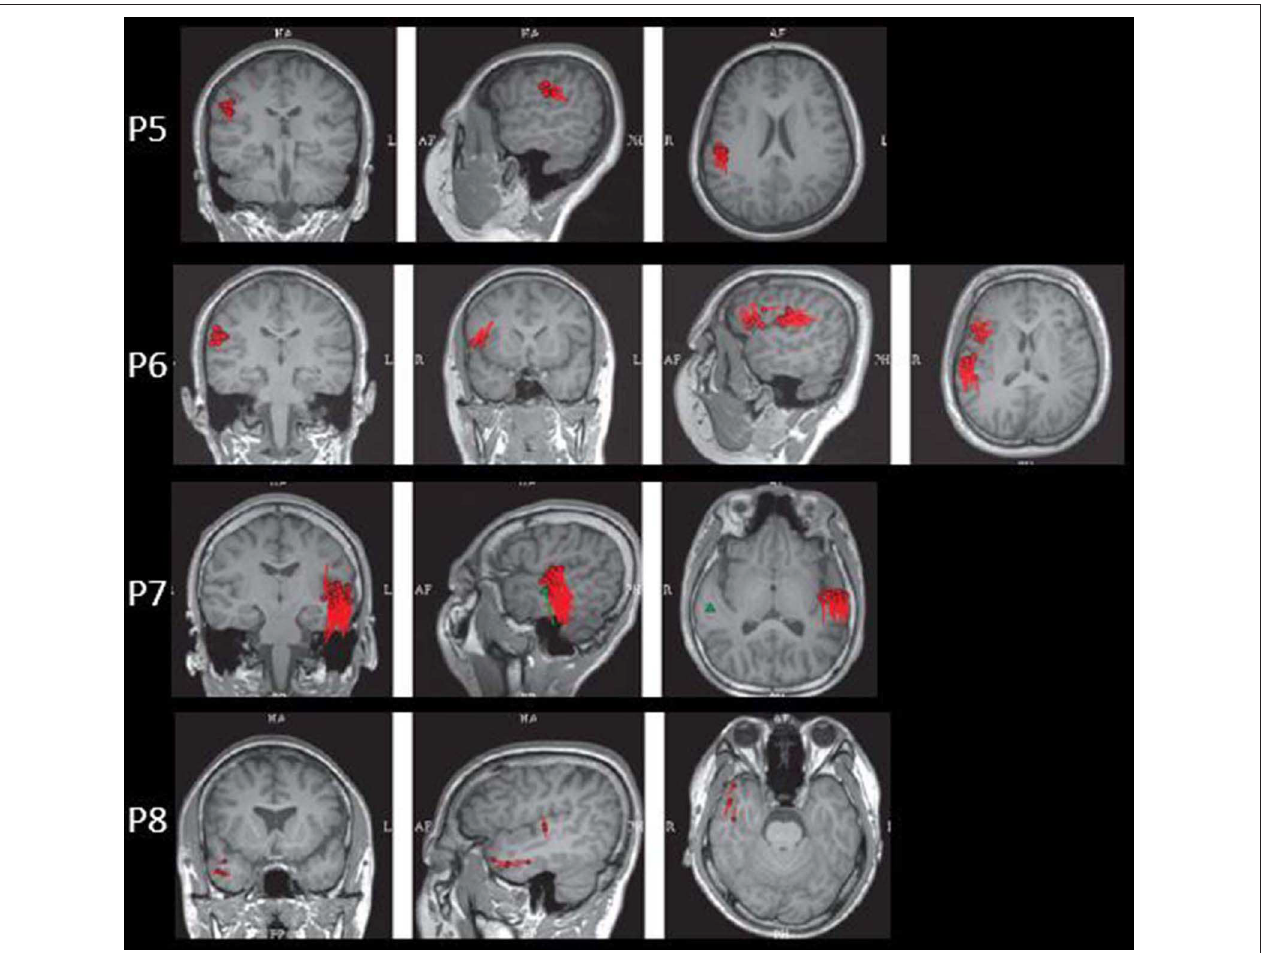
FIGURE 2 | The MEG results of Patient 5–8 in coronal, sagittal, and axial